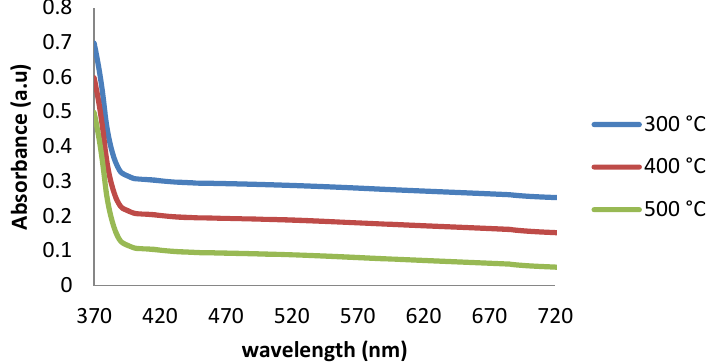
Fig.7: The optical absorption spectra of ZnO nanostructures prepared by hydrothermal method using 2.5 M NaOH with different annealing temperatures (300,400 and 500) °C Optical band gap energy of